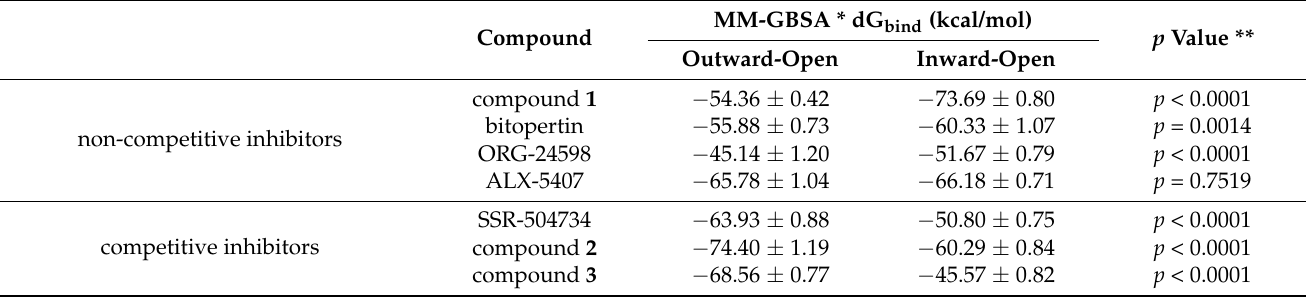
Table 1. MM-GBSA binding free energy values for the noncompetitive and competitive inhibitors in a complex with GlyT-1 in the inward-open and outward-open states. MM-GBSA energy value was calculated for the frames derived from the last 2 ns of 50-ns MD